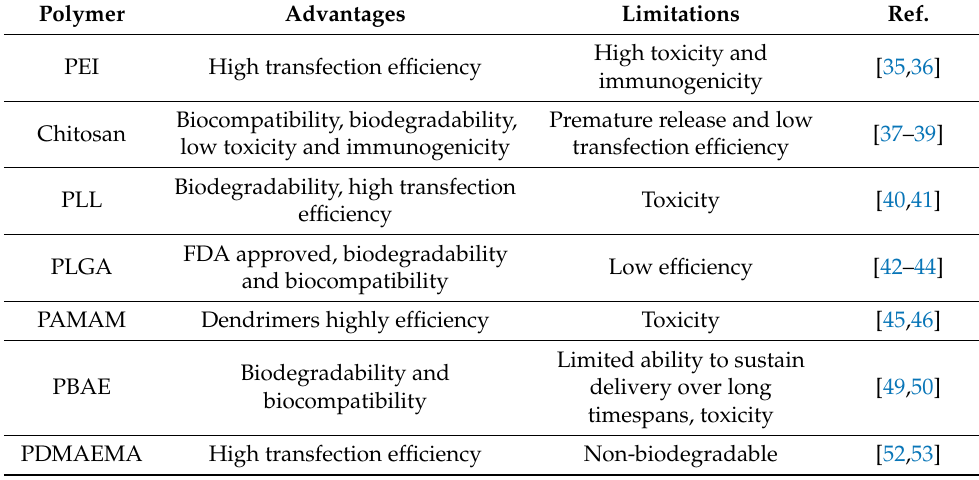
Table 1. Polymers for RNA